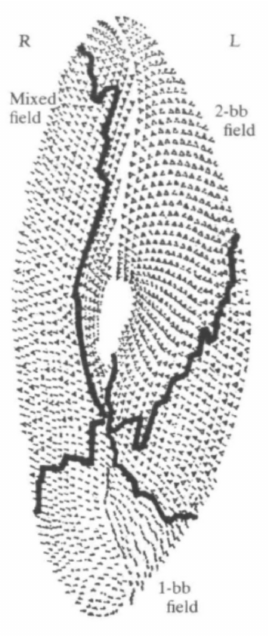
Figure 16. A camera lucida drawing shows the ventral surface of Paramecium . The anterior two basal body field (2-bb field), or invariant zone, contains all two basal body units, each with a cilium arising. The mixed field wraps around the cell and contains cortical units with either a single- or double-basal body. In this region, only the posterior of the basal bodies has a cilium arising from it. The single basal body field (1-bb field) at the posterior of the cell contains cortical units with only one basal body, each with a cilium arising (Image from [96], reviewed in [98]). Reproduced with